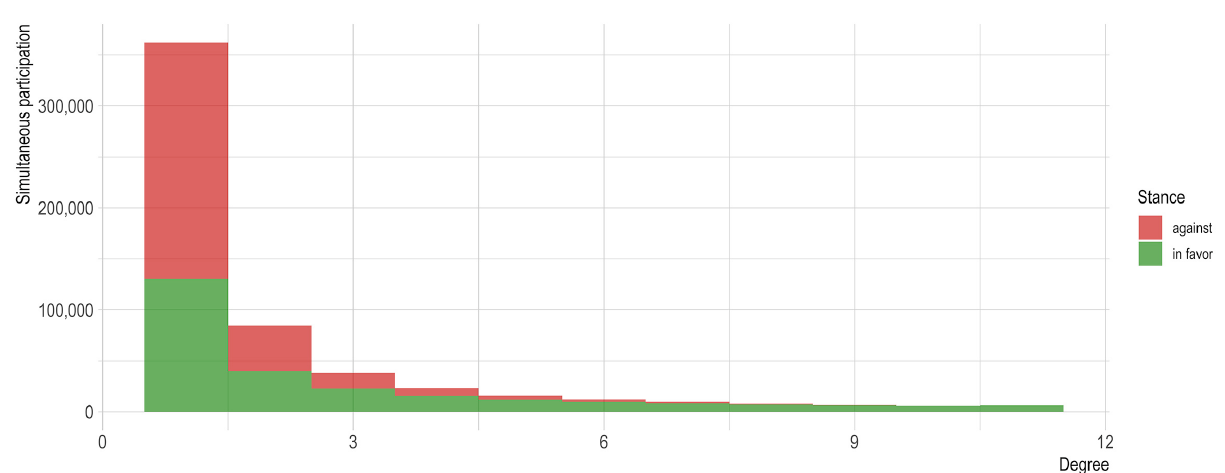
Figure 3. Simultaneous participation histogram of hashtag users. government supporters, was quickly dropped after the opposition started using it as a satire.